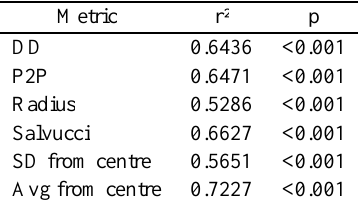
Figure 11. Optimum radius threshold against average point-to- point distance within fixations per participant after application of the Radius metric for fixation identification Table 3. Significance of linear regressions of optimum threshold against average point-to-point distance per participant recording for each of the